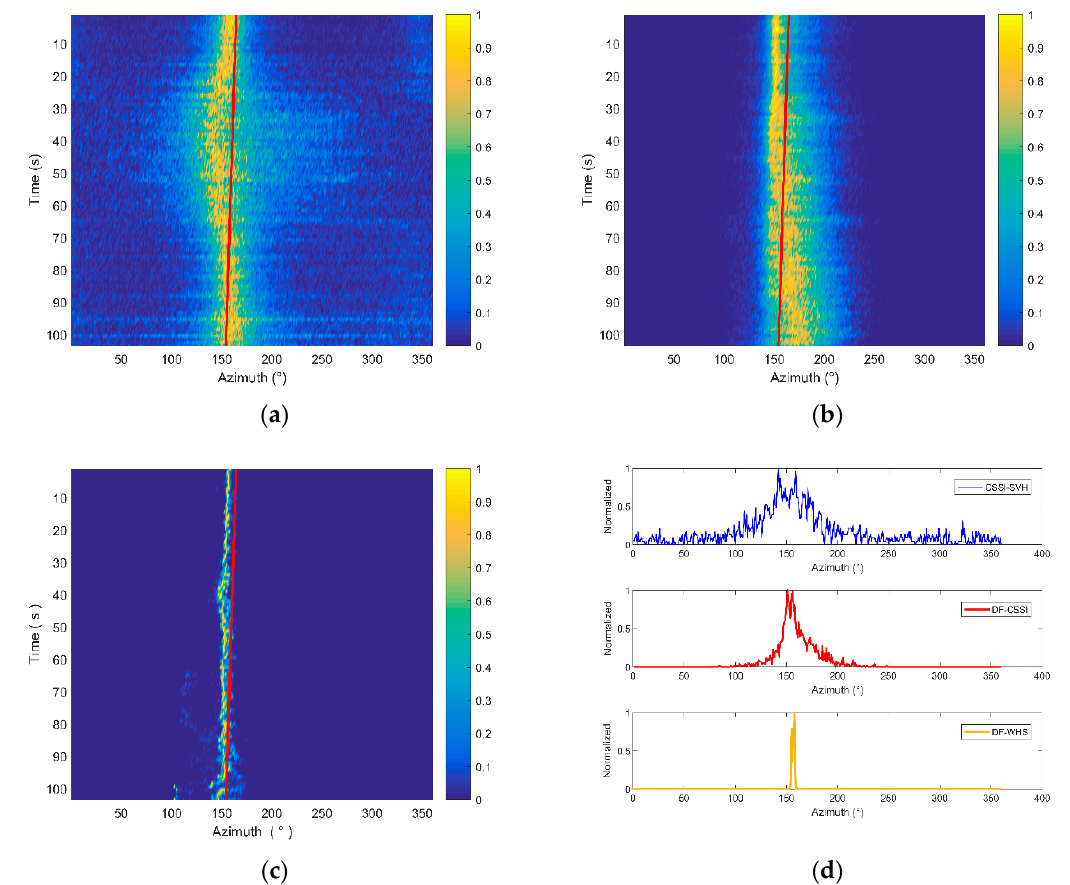
Figure 15. Results of the processing band of 100–1500 Hz. ( a ) Cross-spectral sound intensity method of single vector hydrophone (CSSI-SVH); ( b ) data fusion algorithm for the vector hydrophone vertical array based on the cross-spectral sound intensity method (DF-CSSI); ( c ) the DF-WHS algorithm; ( d ) the beam pattern of the three methods.